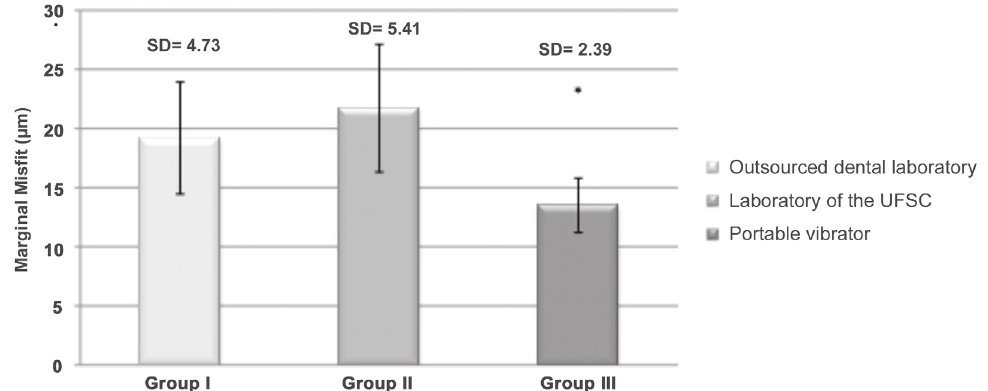
Figure 4- Means and standard deviations(SD) of the misfit (μm) for the three groups. *statistically significant difference in comparison with the other groups